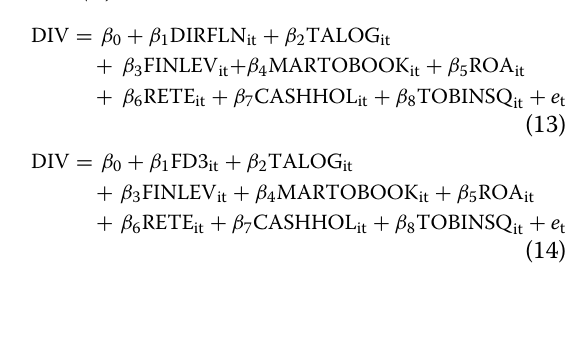
Table 5 Alternative board gender diversity index and dividend payout policy